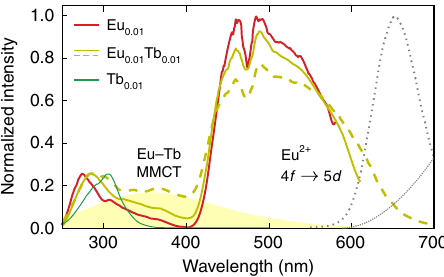
Fig. 2 Photoluminescence excitation spectra. Photoluminescence excitation spectra of Eu 2 + - and Tb 3 + -codoped CaS phosphors. Spectra were collected for the Tb 3 + 4 f – 4 f emission (545 nm, green solid lines), the Eu 2 + 5 d – 4 f emission (650 nm, red and gold solid lines) and the Eu – Tb metal-to-metal charge transfer (MMCT) emission (790 nm, dashed line). The estimated spectral pro fi le of the Eu – Tb MMCT excitation band is highlighted in yellow. The Eu 2 + 5 d – 4 f and Eu-Tb MMCT emission spectral pro fi les are shown in addition (gray dotted lines). All spectra were measured at